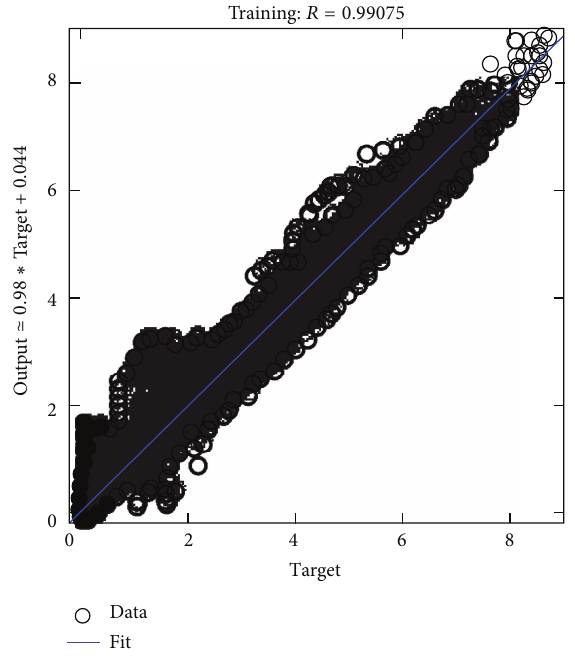
Figure 8: Training correlation coefficient.